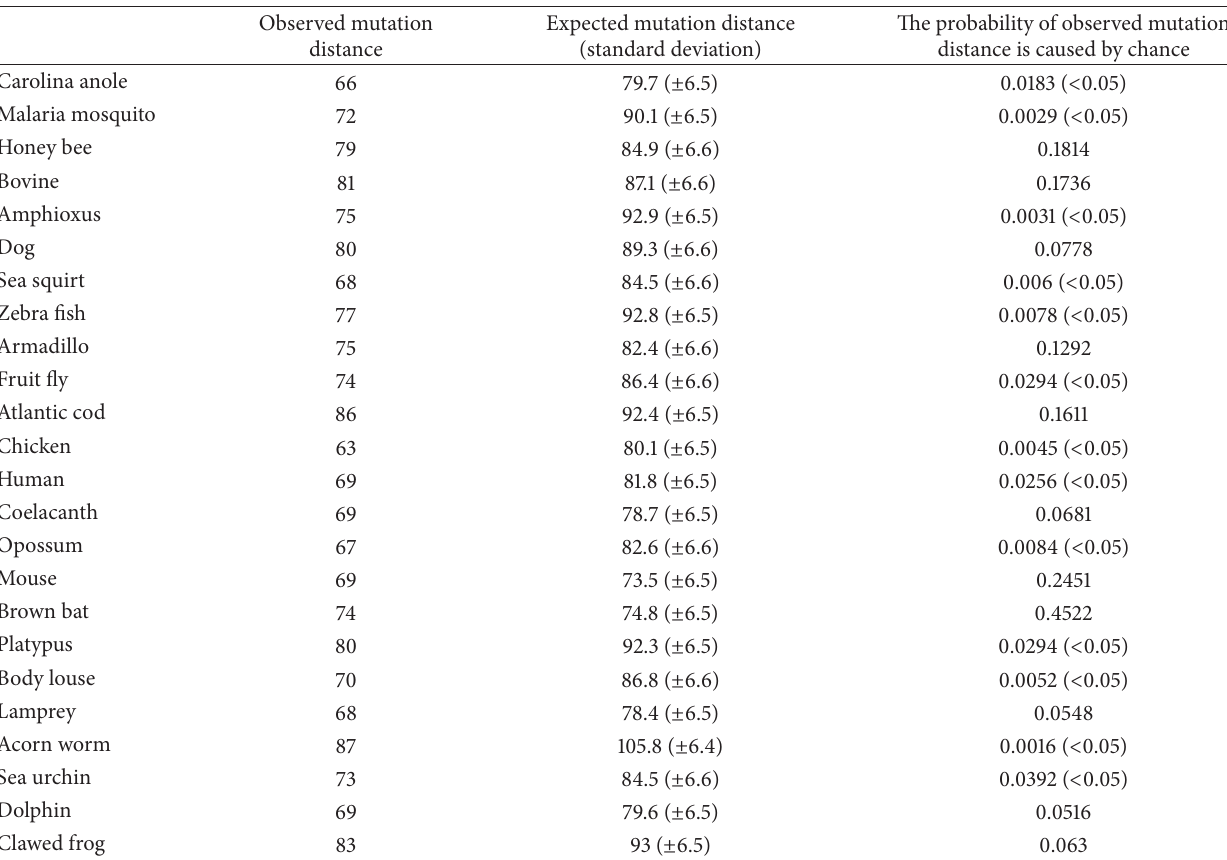
Table 3: Mutation distance between 24 metazoan rhodopsin’s ancestral states and their evolutionarily closest microbial rhodopsin’s ancestral state (Figure 3). Within test region, the average mutation distance between existent microbial and metazoan rhodopsins is 119 ± 5 mutations in the first and second codon